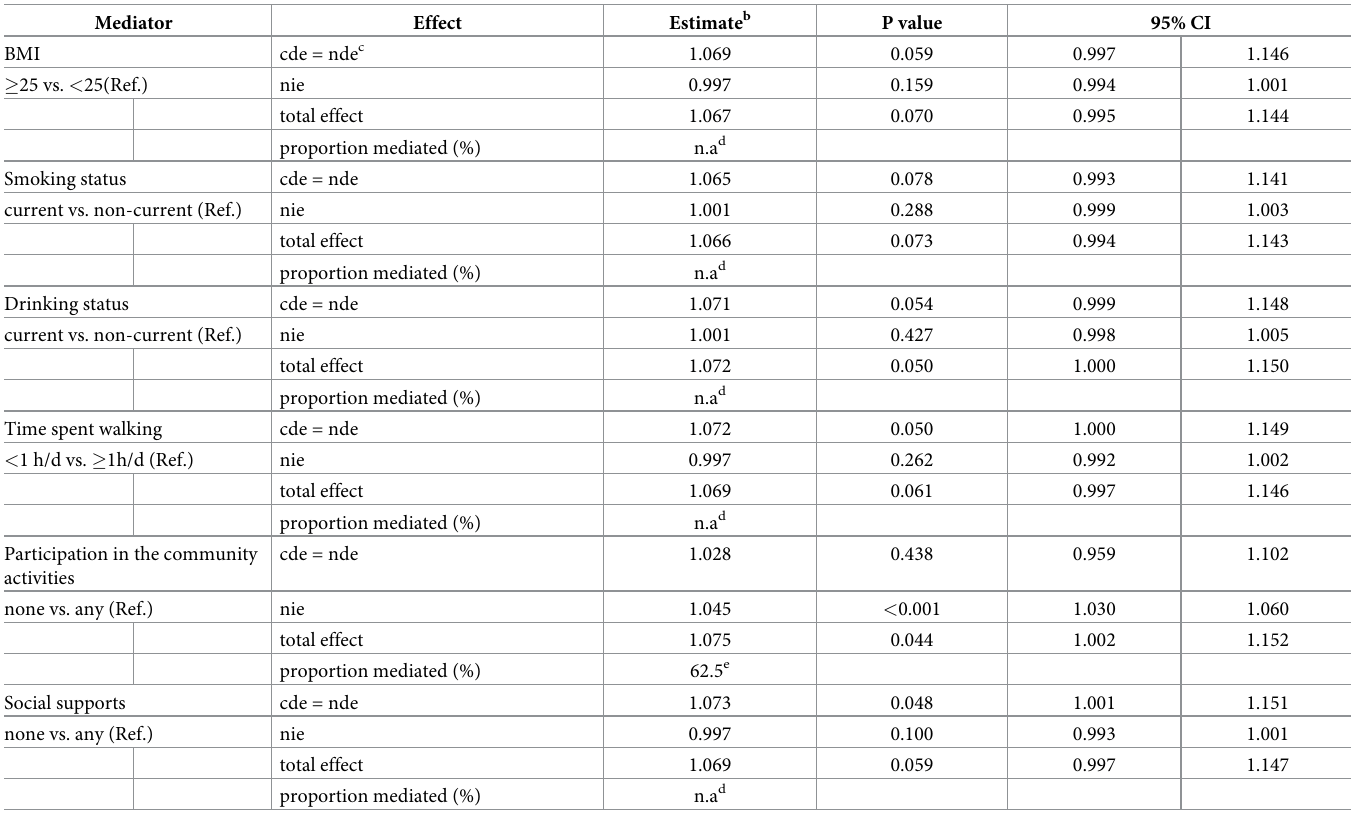
Table 7. Mediation analyses of the relationship between education level [below upper secondary education (Ref.) vs. upper secondary education and above] and incident functional disability, for participants aged � 75 years (n = 3,342) a , Ohsaki city, Japan, 2006–2015.